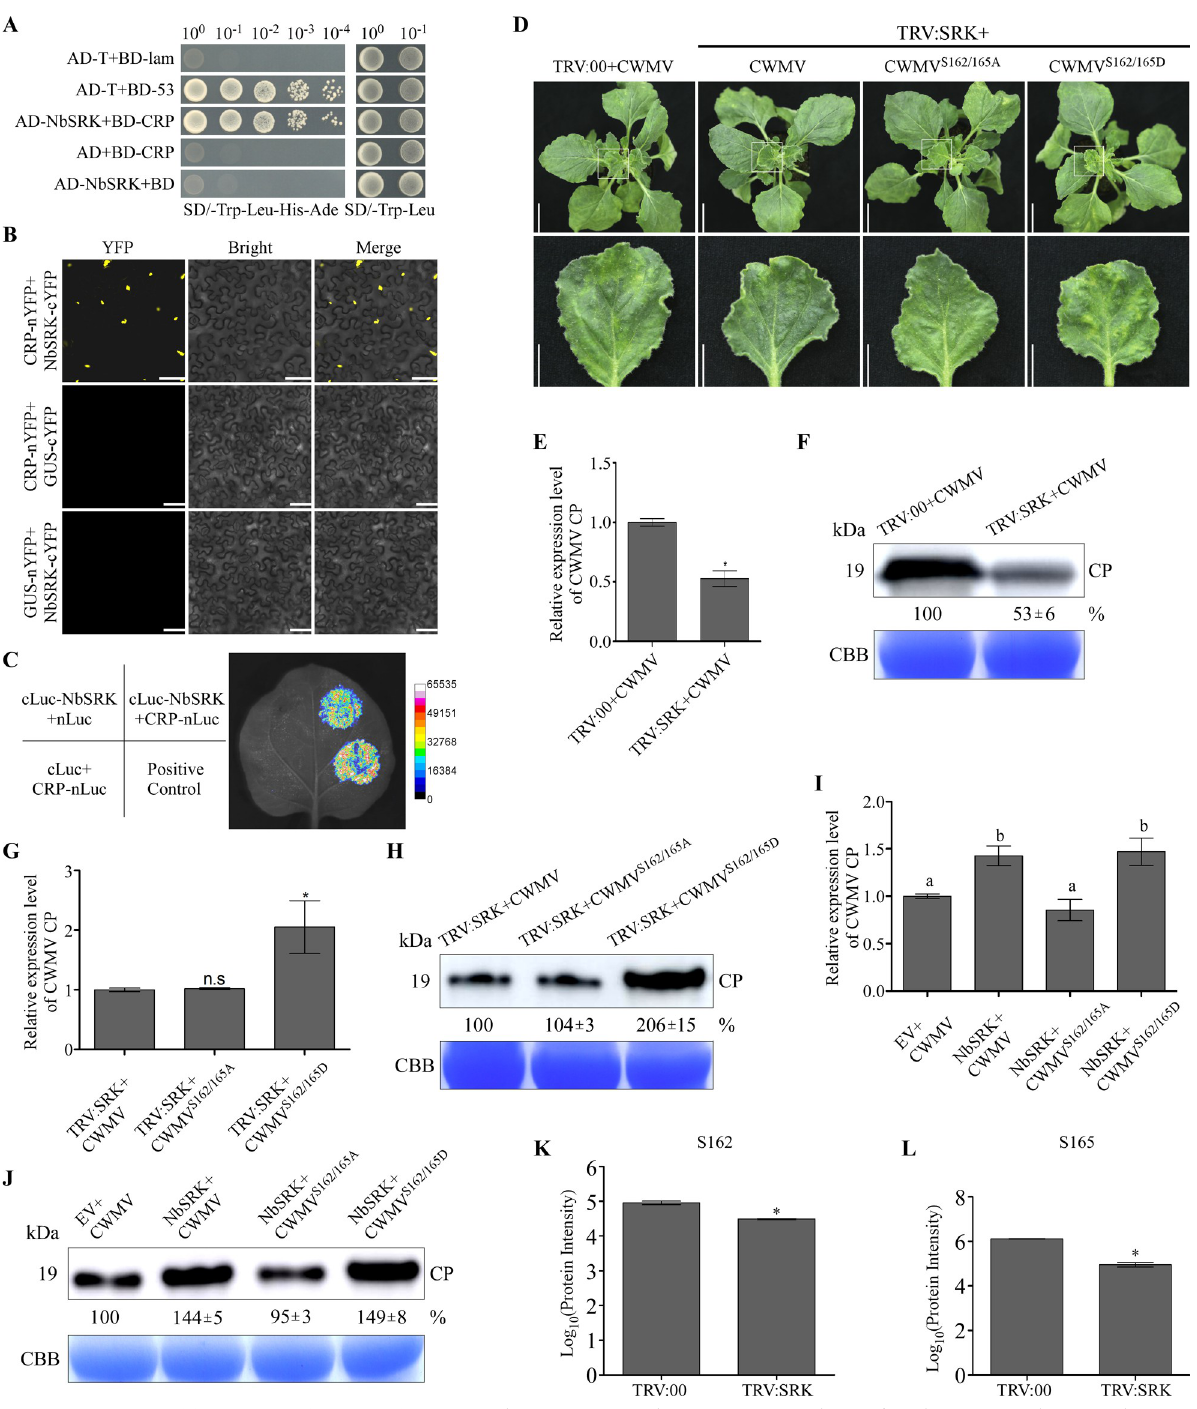
Fig 4. SRK is required for CWMV infection in plant. A , B and C. YTH, BiFC and LCI assay were used to confirm the interaction between NbSRK and CRP. D. Systemic mosaic symptoms on the TRV:00+CWMV-, TRV:SRK+CWMV-, TRV:SRK+CWMV S162/165A -, or TRV:SRK+CWMV S162/165D - inoculated N . benthamiana plants. Photographs were taken at 21 days post CWMV inoculation. Scale bar = 5 cm (upper panel), Scale bar = 2 cm (lower panel). E. Quantitative RT-PCR analysis of relative expression level of CWMV CP in the TRV:00+CWMV- or TRV:SRK+CWMV-inoculated N . benthamiana plants. The data presented are the means ± SD, determined using the Student’s t -test. Each treatment had three biological replicates. � , P < 0.05. F. The accumulation of CWMV CP in the assayed N . benthamiana plants was determined through western blot analysis using a CWMV CP specific antibody at 21 dpi. The CBB-stained gel is used to show sample loadings. G. Relative expression levels of CWMV CP in the TRV:SRK +CWMV-, TRV:SRK+CWMV S162/165A -, or TRV:SRK+CWMV S162/165D -inoculated N . benthamiana plants were determined through qRT-PCR.